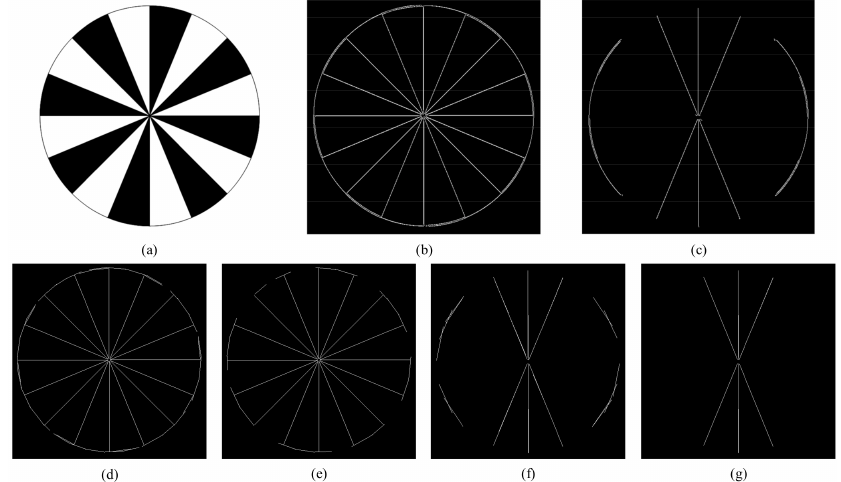
Figure 18. Comparison of processing effects of multi-angle line segments. ( a ) Noise-free hand-drawn image; ( b ) Divided image of π /8; ( c ) Processing picture of the hardware algorithm; ( d , e ) Pictures of line segments detected by the original LSD algorithm; ( f , g ) Processing pic-tures of the algorithm IP core.